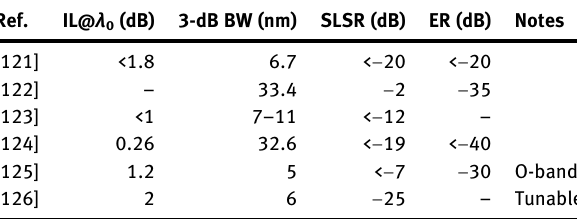
Table  : Performance comparison of recently demonstrated subwavelength-enhanced WDM (de)multiplexers based on contra DC. Ref.